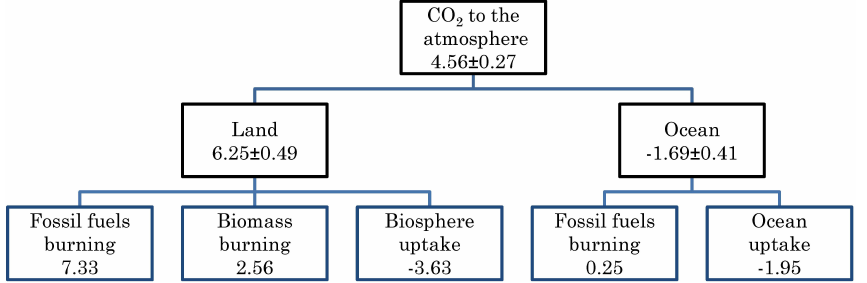
Fig. 3. Mean global carbon budget of 2002–2007 inferred from atmosphere observations. Carbon budgets over land and ocean are partitioned further based on our inverted fluxes and estimated fluxes from fossil fuels consumption (http://carbontracker.noaa.gov, 2009), biomass burning (Randerson et al., 2007) and ocean uptake (Buitenhuis et al., 2006) (unit: PgCyr − 1